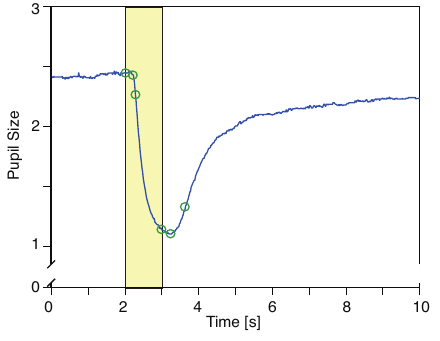
Figure 5. Comparison of DC components between stimulus